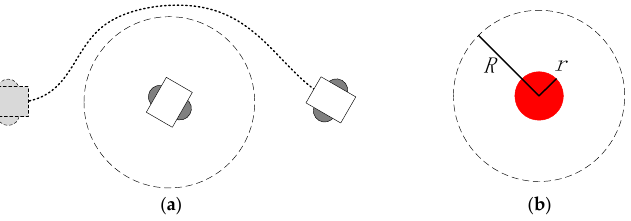
Figure 5. Illustration of obstacle avoidance area and its simplification. In ( a ), the vehicle traveling outside the area is considered to avoid obstacles; ( b ) is a simplified representation of the obstacle avoidance area during the experiment.